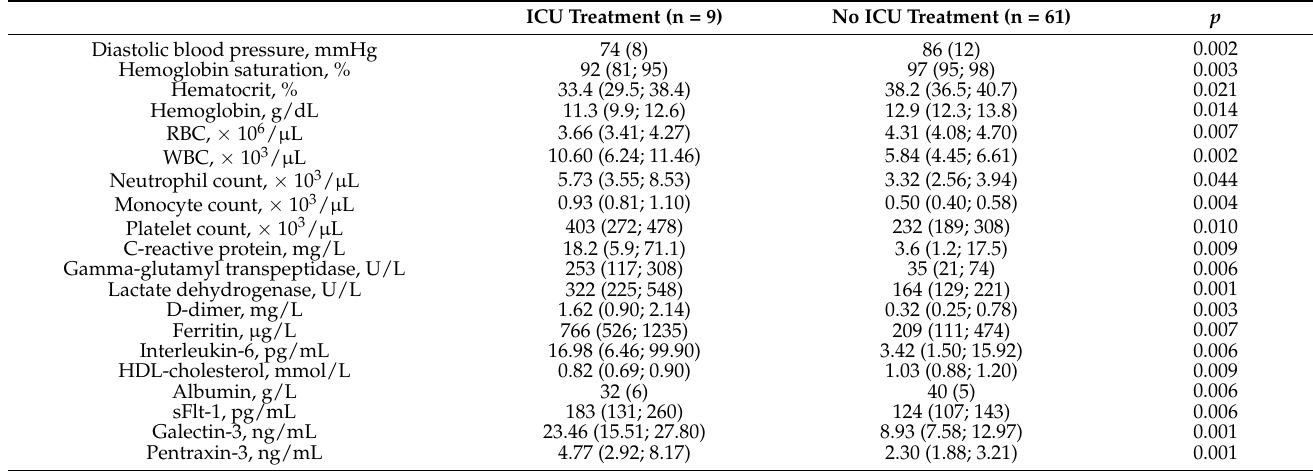
Table 4. Statistically significant differences between patients who required and did not require treatment in intensive care unit (ICU) during hospital stay. Data are shown as median (IQR) or mean (SD).